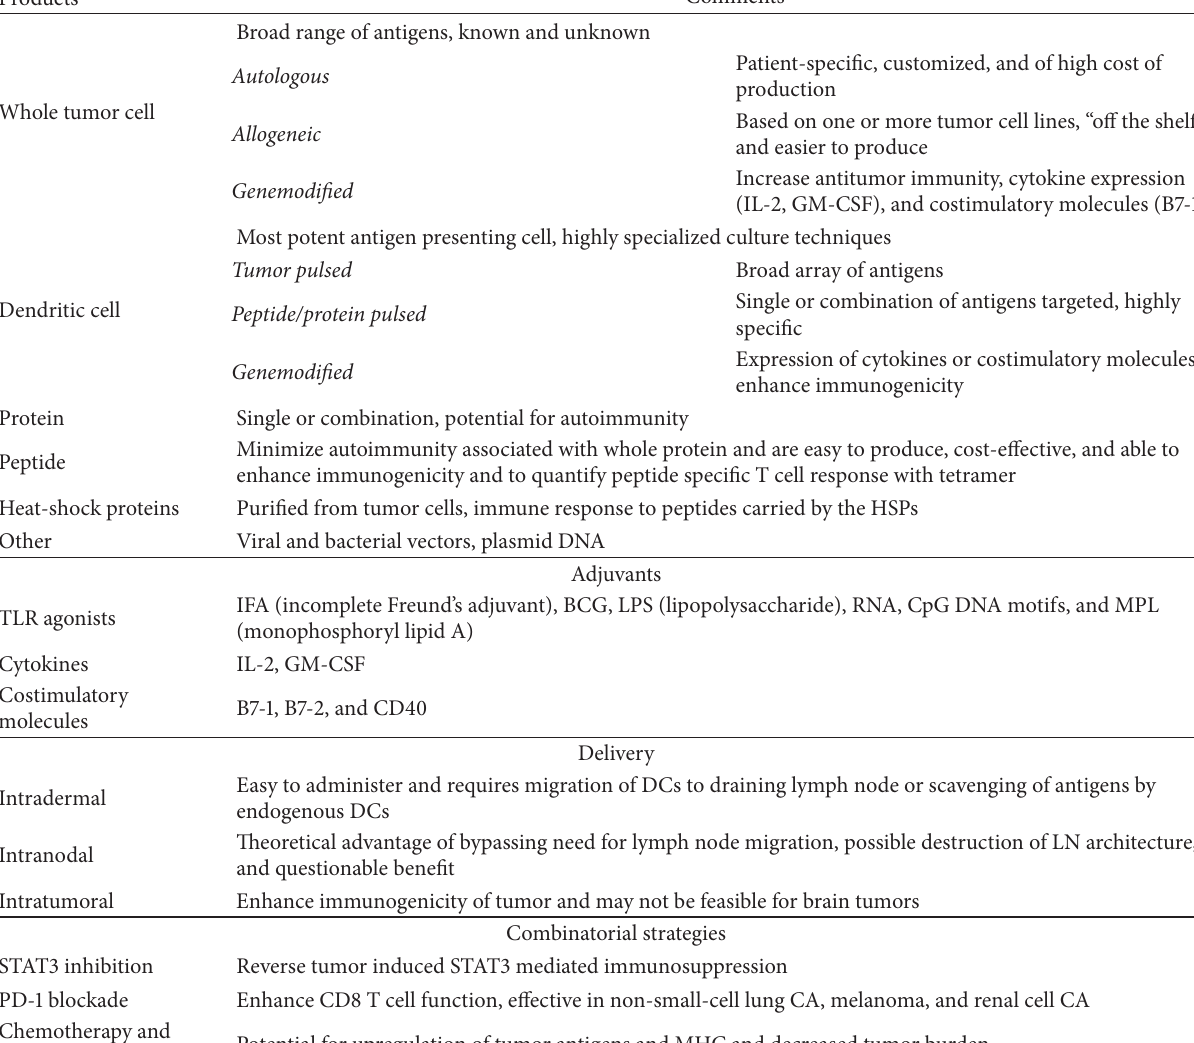
Table 1: Vaccine